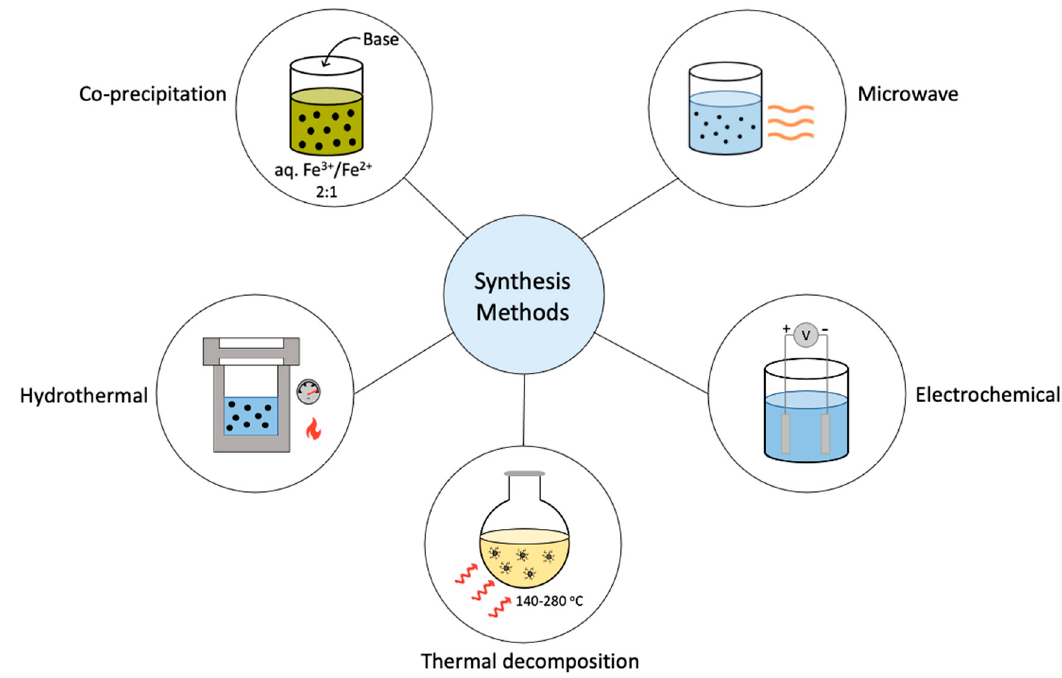
Figure 1. Synthesis methods commonly employed for the preparation of magnetic nanoparticles.